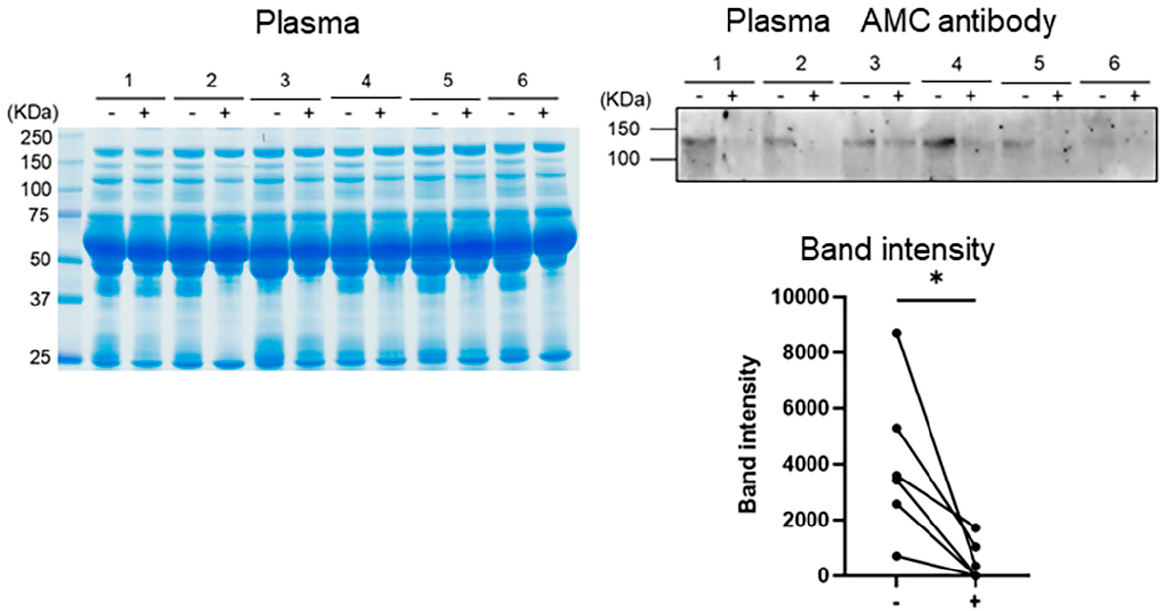
Figure 4. Reduction in citrullinated protein in RA patients treated with tocilizumab. Sera from RA patients at baseline or at 6 months after tocilizumab (TCZ) treatment were separated by SDS-PAGE then stained with CBB or were subjected to Western blot analysis with anti-modified citrulline (AMC) antibodies. Bars show means ± SEMs. p values were calculated using the unpaired t -test; * p < 0.05.